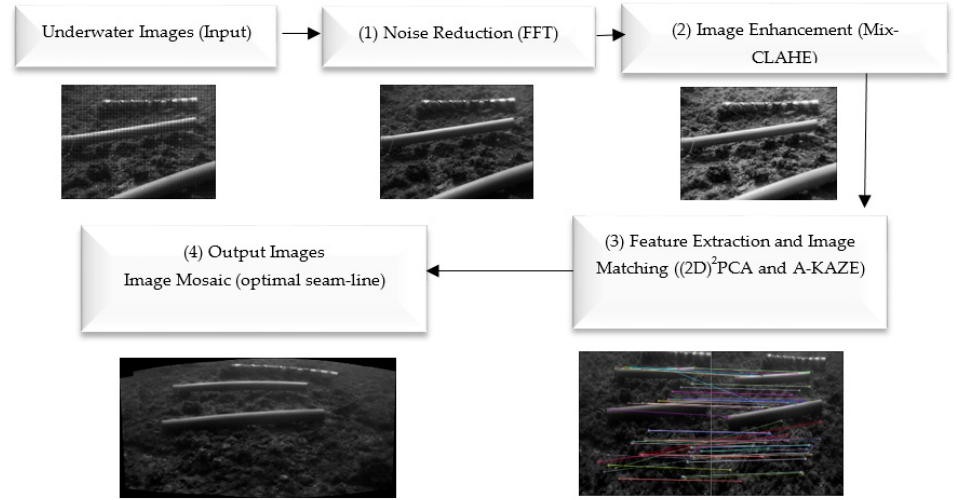
Figure 1. The flow chart of proposed method.